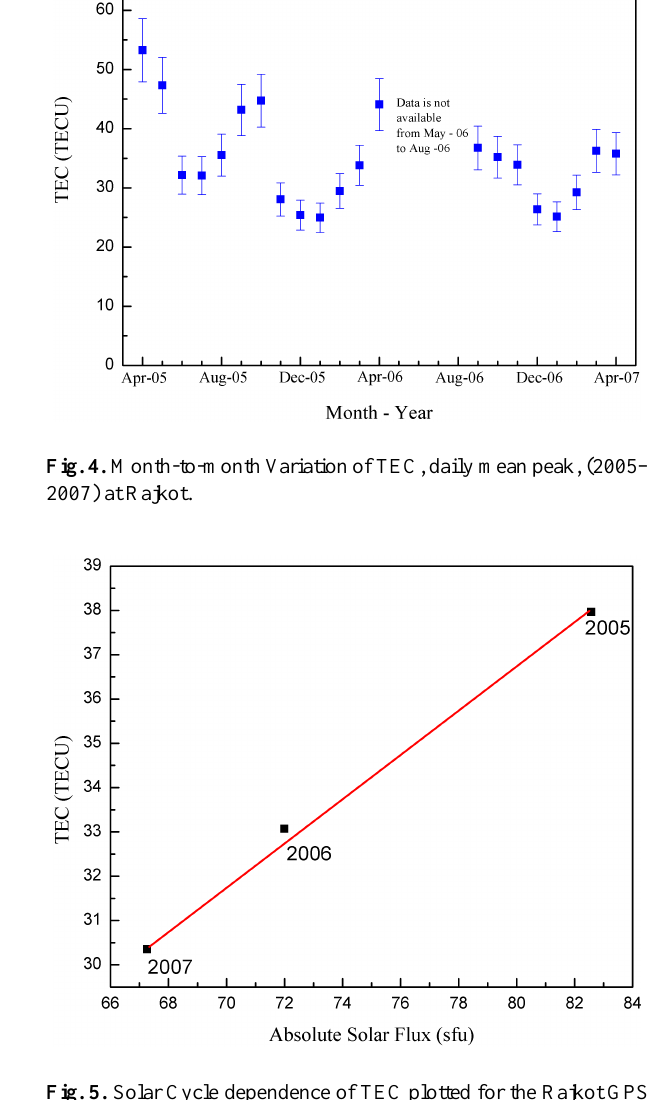
Fig. 5. Solar Cycle dependence of TEC plotted for the Rajkot GPS